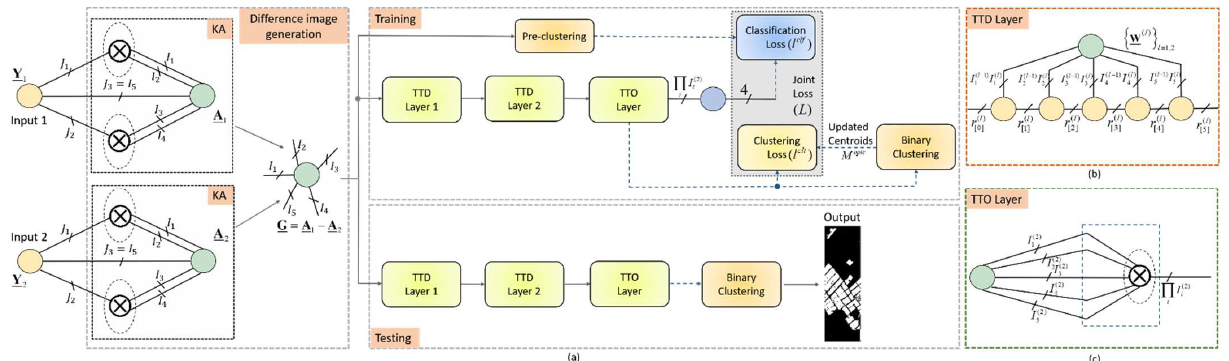
Figure 4. Framework of the proposed STT for multitemporal HSI change detection. ( a ) Overall framework of STT, ( b ) tensor train decomposition (TTD) layer, ( c ) tensor train output (TTO) layer. Algorithm 1. Pseudocode of the proposed UTT for multitemporal HSI change detection.